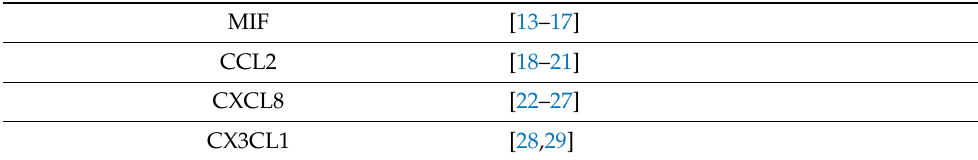
Table 1. Citations of depicted secreted proteins presented in Figure